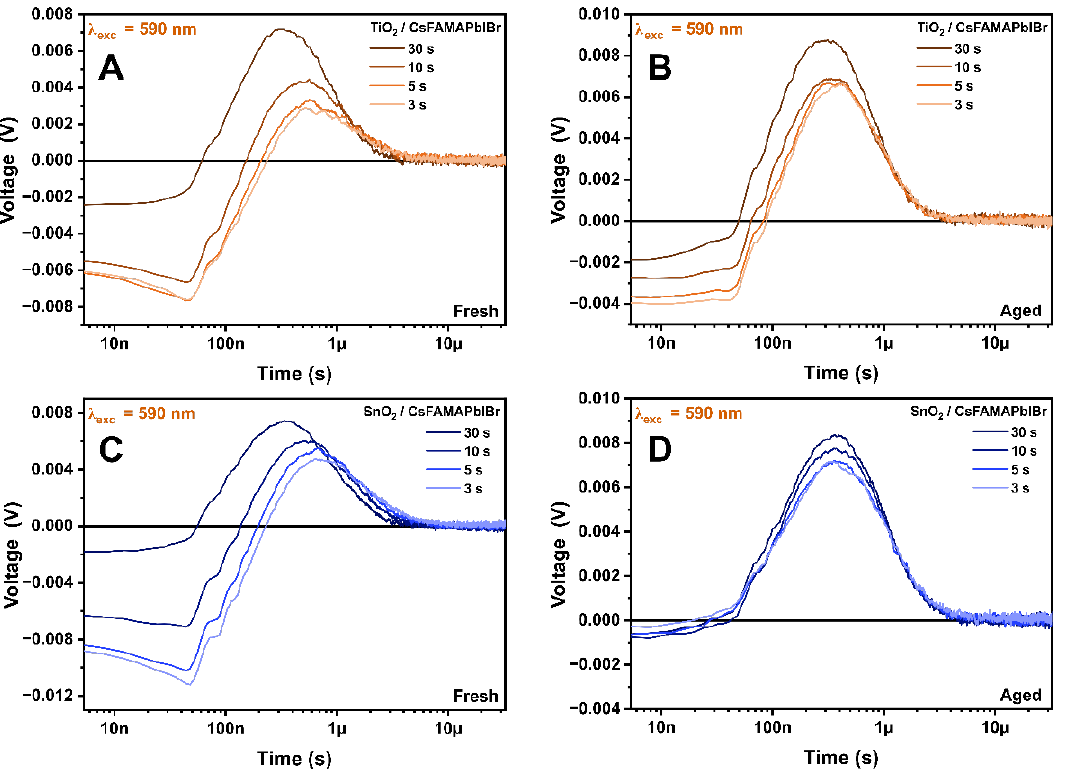
Figure 4. TPV transients in logarithm scale obtained at different illumination times at 1 Sun intensity for fresh and aged CsFAMAPbIBr on TiO 2 ( A , B ) and SnO 2 ( C , D ) ESC.